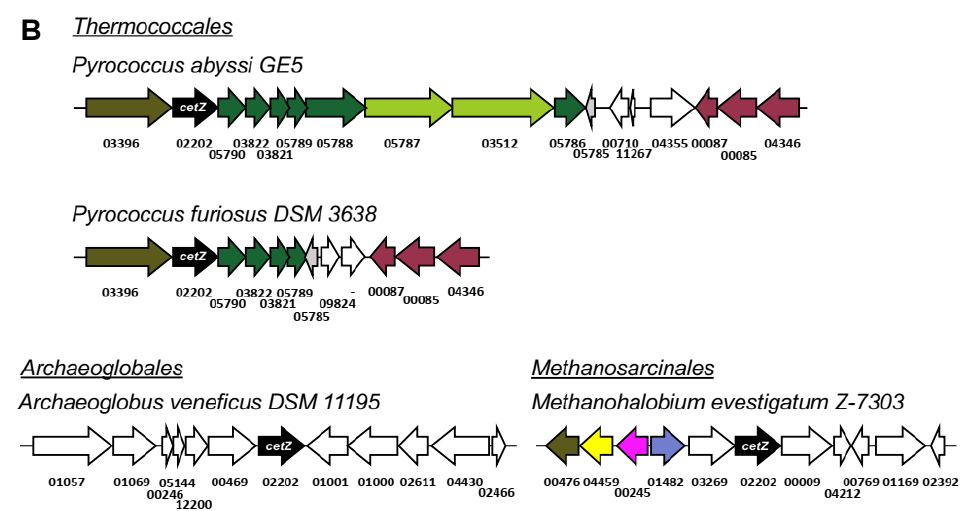
Figure 8. Conserved portions of the 40kb cetZ genomic regions from non-Haloarchaea Euryarchaeota. ( A ) The 20 kb regions on either side of the cetZ gene were analysed from 27 species of the orders Thermococcales (15), Archaeoglobales (3), Methanosarcinales (6), and Methanomicrobiales (3). Table listing the most frequently observed arCOGs and their occurrence in 27 cetZ genomic regions from each order. ( B ) Examples of cetZ genomic regions, showing their conserved residues only (except in the case of Archaeoglobus veneficus DSM 11195 , which has no conserved regions). The genes encoding cetZ are represented in black, and genes belonging to arCOGs present within at least 10 of the cetZ genomic regions are coloured according to their COG category as detailed in Table S2, and arCOGIDs are listed beneath each gene. arCOGs encoding uncharacterised proteins which are present in at least 10 of the cetZ genomic regions are represented in grey, and arCOGs not present in at least 10 of cetZ genomic regions are represented in white. Four arCOGs (00476, 04459, 00245, and 01482) were not present in majority of all cetZ genomic regions, but were highly conserved within the order Methanosarcinales; these arCOGs are coloured according to their COG category.